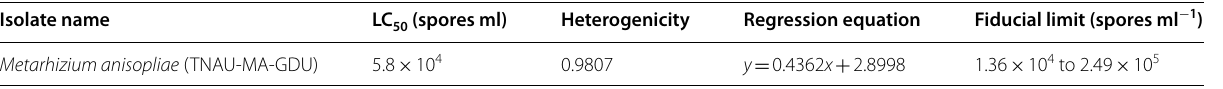
Table 1 Concentration mortality response of Spodoptera frugiperda to Metarhizium anisopliae